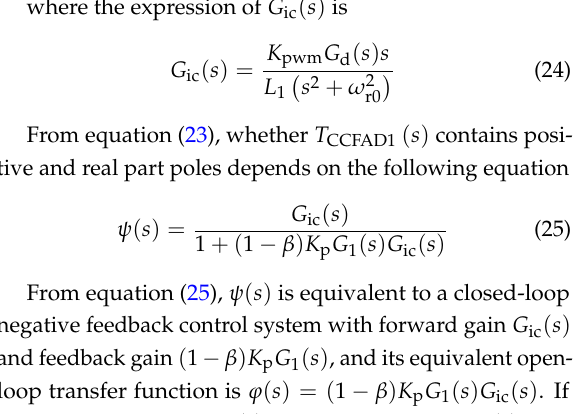
Fig. 14. Bode diagram of T CCFAD1 ( s ) .